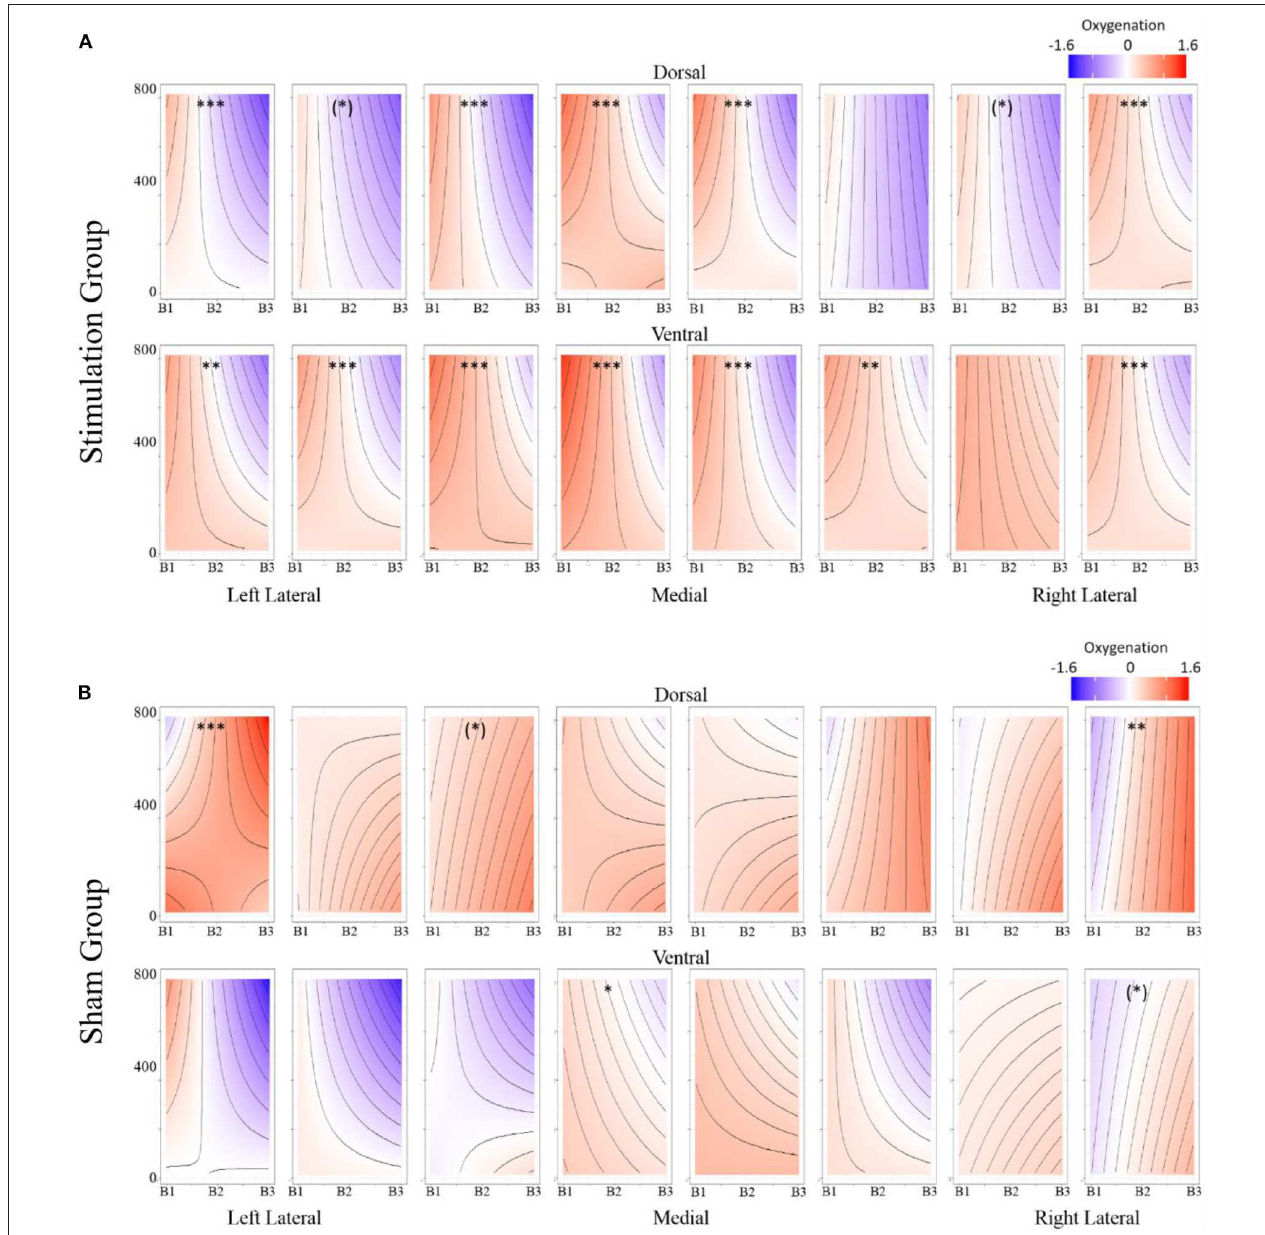
FIGURE 9 | (A) Stimulation condition three-way interaction between relationship of spatial memory error distance and oxygenation as a function of experimental block. Dorsal optodes are odd numbered, ventral optodes are even numbered. Optodes are ordered from least on the left to greatest on the right. * p < 0.05, ** p < 0.01, *** p < 0.001. (B) Sham condition three-way interaction between relationship of spatial memory error distance and oxygenation as a function of experimental block. Contrast between sham and stimulation conditions, * p < 0.05, ** p < 0.01, *** p < 0.001.